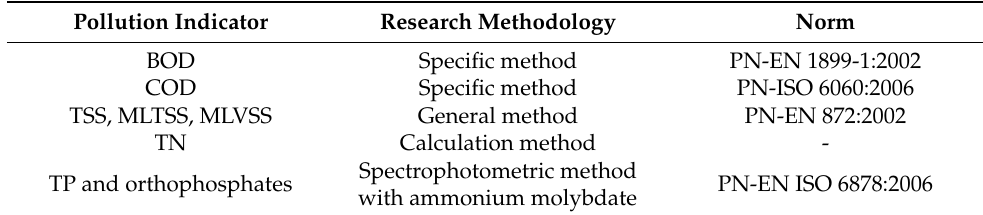
Table 1. Norms and methods for indicating pollution.